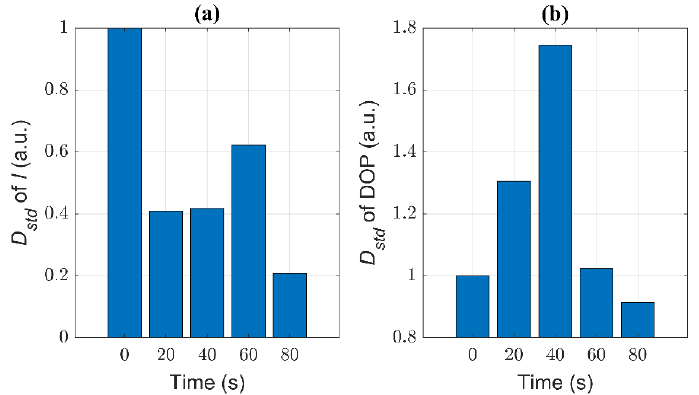
Figure 9. The relative standard deviation of samples with different ST times ( a ) I ; ( b ) DOP.